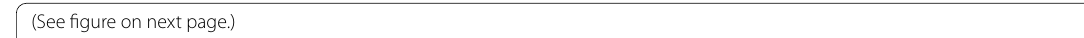
Fig. 7 EDI‑OCT findings in course of VKH, from presentation to a 12‑month follow‑up. A At presentation, the choroid is too thick to be measured (note choroidal folds); B after 2 weeks, the limit of the choroidal space can again be recognized, but choroidal thickness is increased (mean subfoveal thickness 525 13.1 μm); C ‑ E the choroidal thickness progressively decreased; C after 2 months, the choroidal thickness was = ± 493.3 23.5 μm); D after 8 months, the choroidal thickness was 460.3 24.5 μm; and E at 12 months, the choroidal compartment is thinner than ± ± normal (224 ±